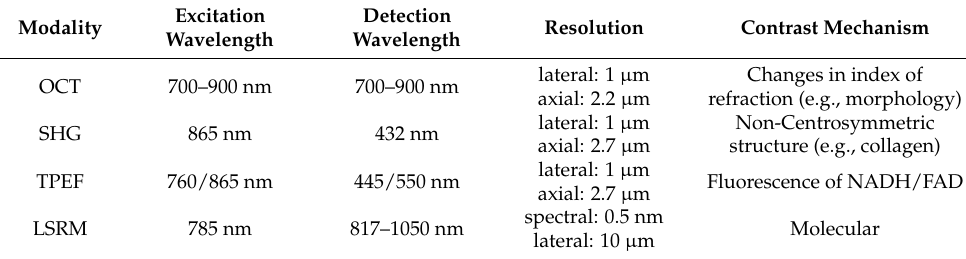
Table 1. System parameters.